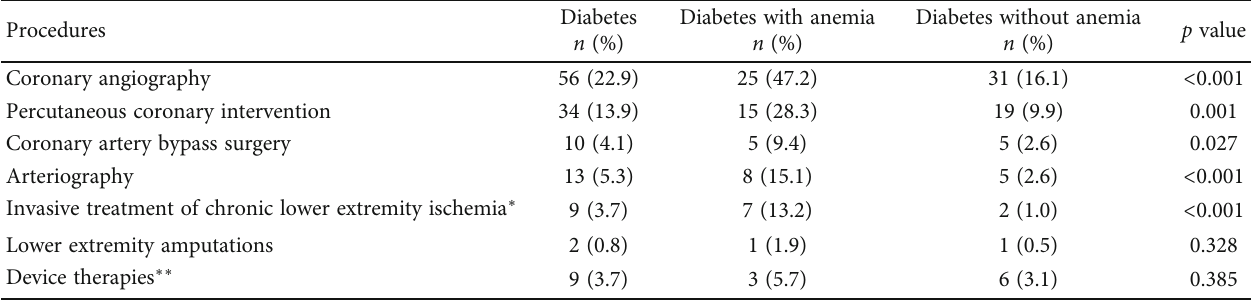
Table 4: Comparison of the frequency of selected medical procedures in di ff erent patient groups.